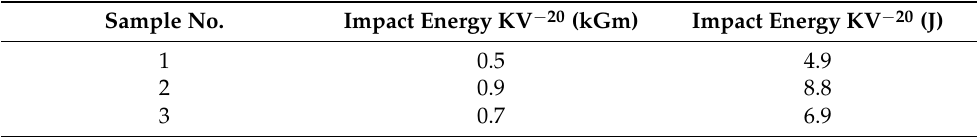
Table 7. Results of the impact strength test of samples from the handy-size bulk carrier 30210 DWT. Sample